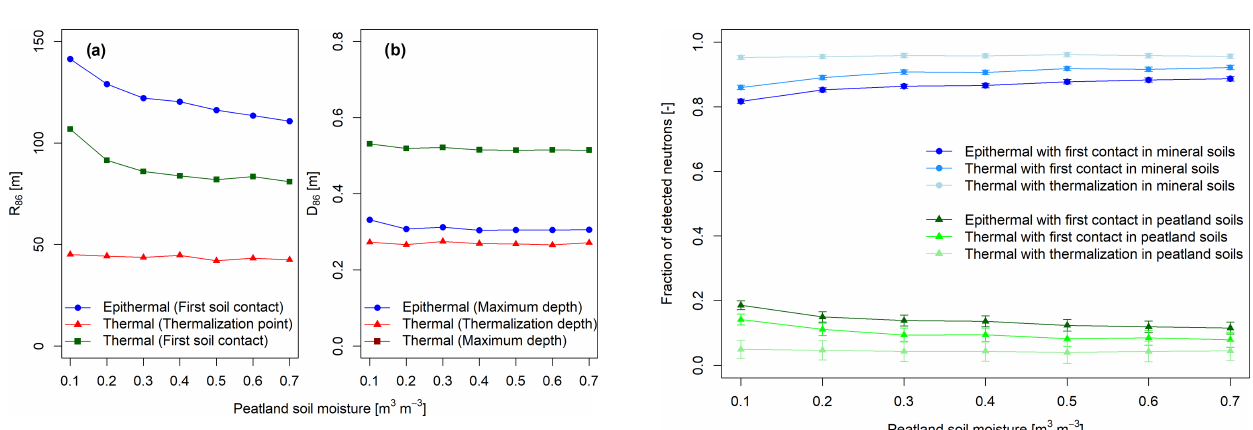
Figure 5. The fraction of detected epithermal and thermal neutrons with increasing soil moisture originating from areas covered with peatland soils and mineral soils in the model domain. For epither- mal neutrons, the point of origin is defined as the point of first soil contact, while for thermal neutrons, both calculations for the point of first contact and the point of thermalization are